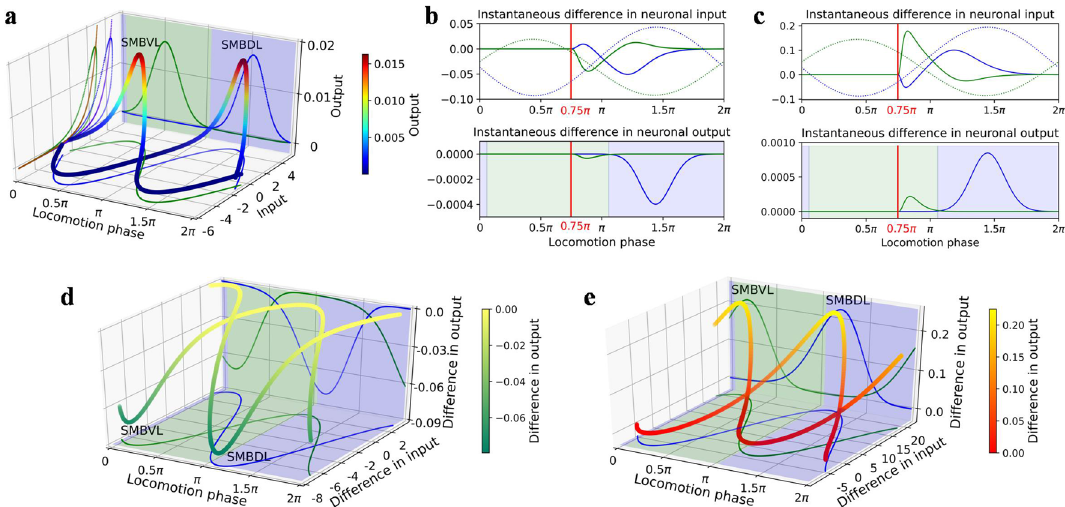
Figure 4. Dynamics of the motor neurons. Green and blue represent SMBVL and SMBDL respectively. The solid-colored curves in 3D sub-graphs show the projections of 3D curves onto each plane. The shaded areas represent the regions of the neuronal output sensitive to neuronal input in the absence of the sensory input. ( a ) Dynamics in the absence of sensory input. The brown and purple curves on the y–z plane show the SISO curves of the SMBVL and SMBDL, respectively. ( b ), ( c ) Instantaneous differences in the neuronal inputs and outputs induced by an up-step ( b ) or a down-step ( c ) at a phase of 0.75π. The dashed lines show the trends of the neuronal inputs with phase when there is no sensory input. ( d ), ( e ) Differences in the neuronal inputs and outputs induced by an up-step ( d ) or a down-step ( e ) at each locomotion